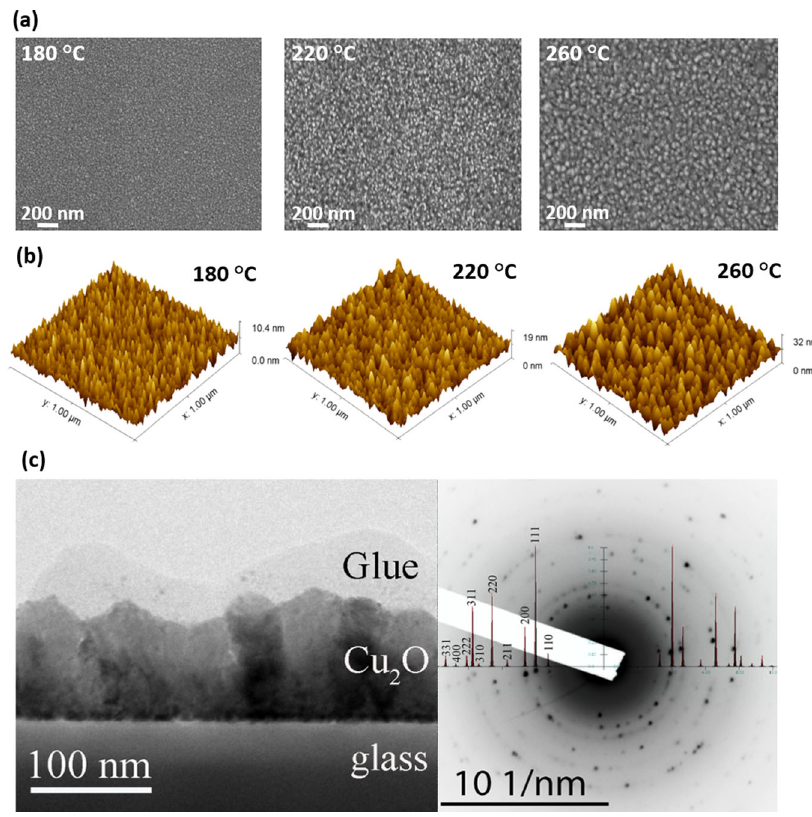
Fig. 2 Morphological characterization. a Secondary electron SEM pictures, b AFM topography images of Cu 2 O thin fi lms deposited on glass at different temperatures, and c Cross-section TEM analysis (left) and selected-area electron diffraction (SAED, rigth) of a Cu 2 O fi lm deposited at 260 °C for 2000 cycles. High-resolution TEM is shown in Supplementary Fig. 4.